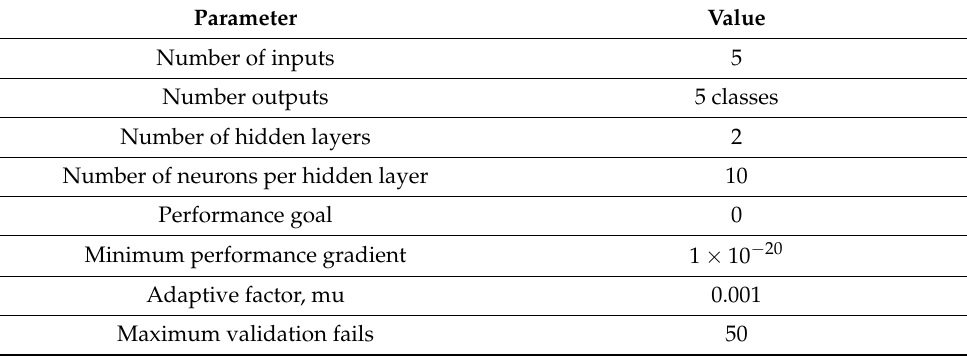
Table 3. Parameters of the neural network